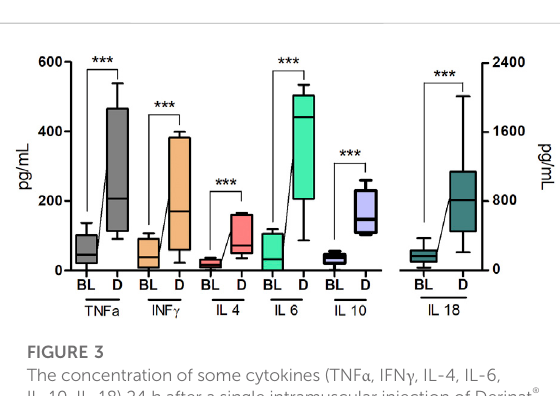
FIGURE 3 The concentration of some cytokines (TNF α , IFN γ , IL-4, IL-6, IL-10, IL-18) 24 h after a single intramuscular injection of Derinat ® at a dose of 7.5